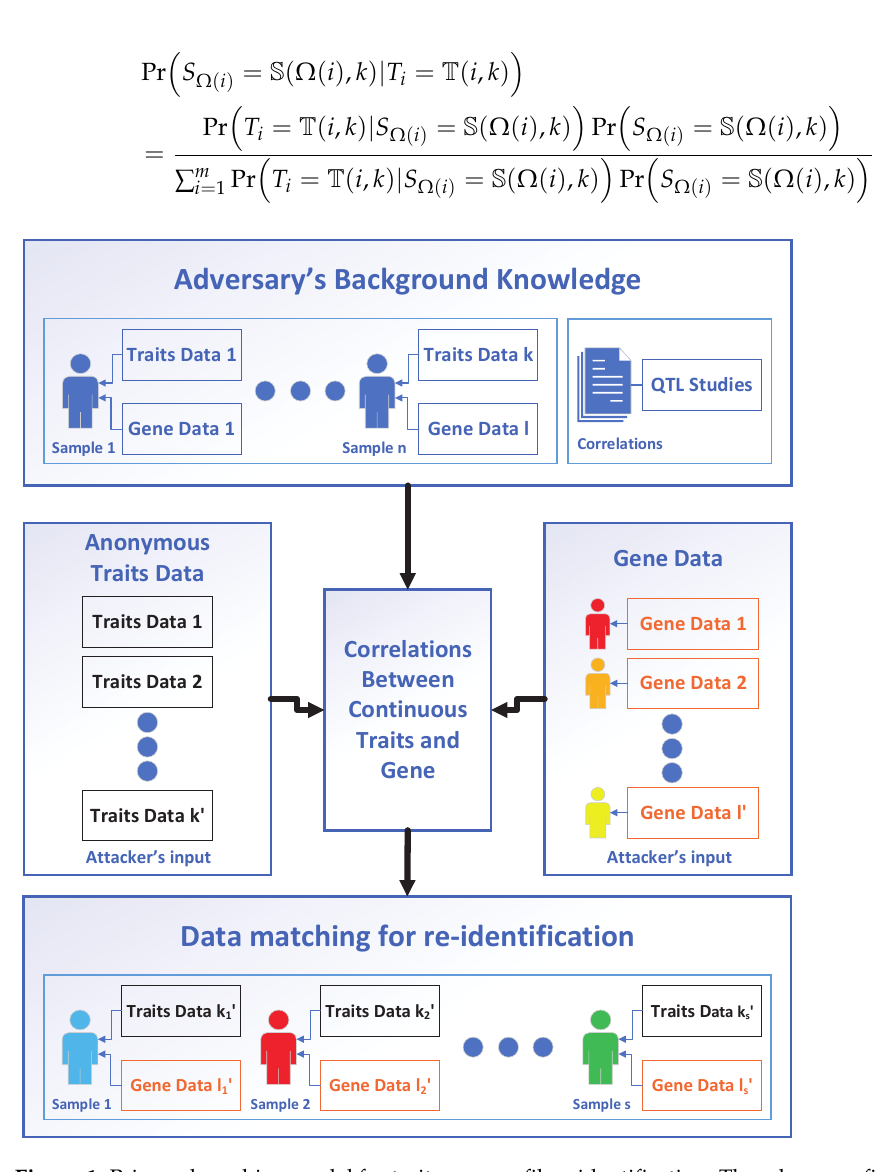
Figure 1. Privacy-breaching model for trait-gene profile reidentification. The adversary first infers the correlations between continuous trait data and gene data (central box) with training datasets (upper box left) or existing research results (upper box right) and then maps the anonymous continuous trait profile (coloured with black in the left box) to the genotype (coloured with orange in the right box) with correlation obtained for reidentification. Then, the adversary verifies whether an individual with the continuous trait data is the member of the genotype dataset. If the matching between the continuous trait profile and genotype is sufficiently significant, it is considered correct (lower box, reidentified individuals are indicated as human shapes with the same colour of that in the right box). Each human shape represent an individual; each trait data or gene data in a box represent a continuous trait profile or a genotype profile from an